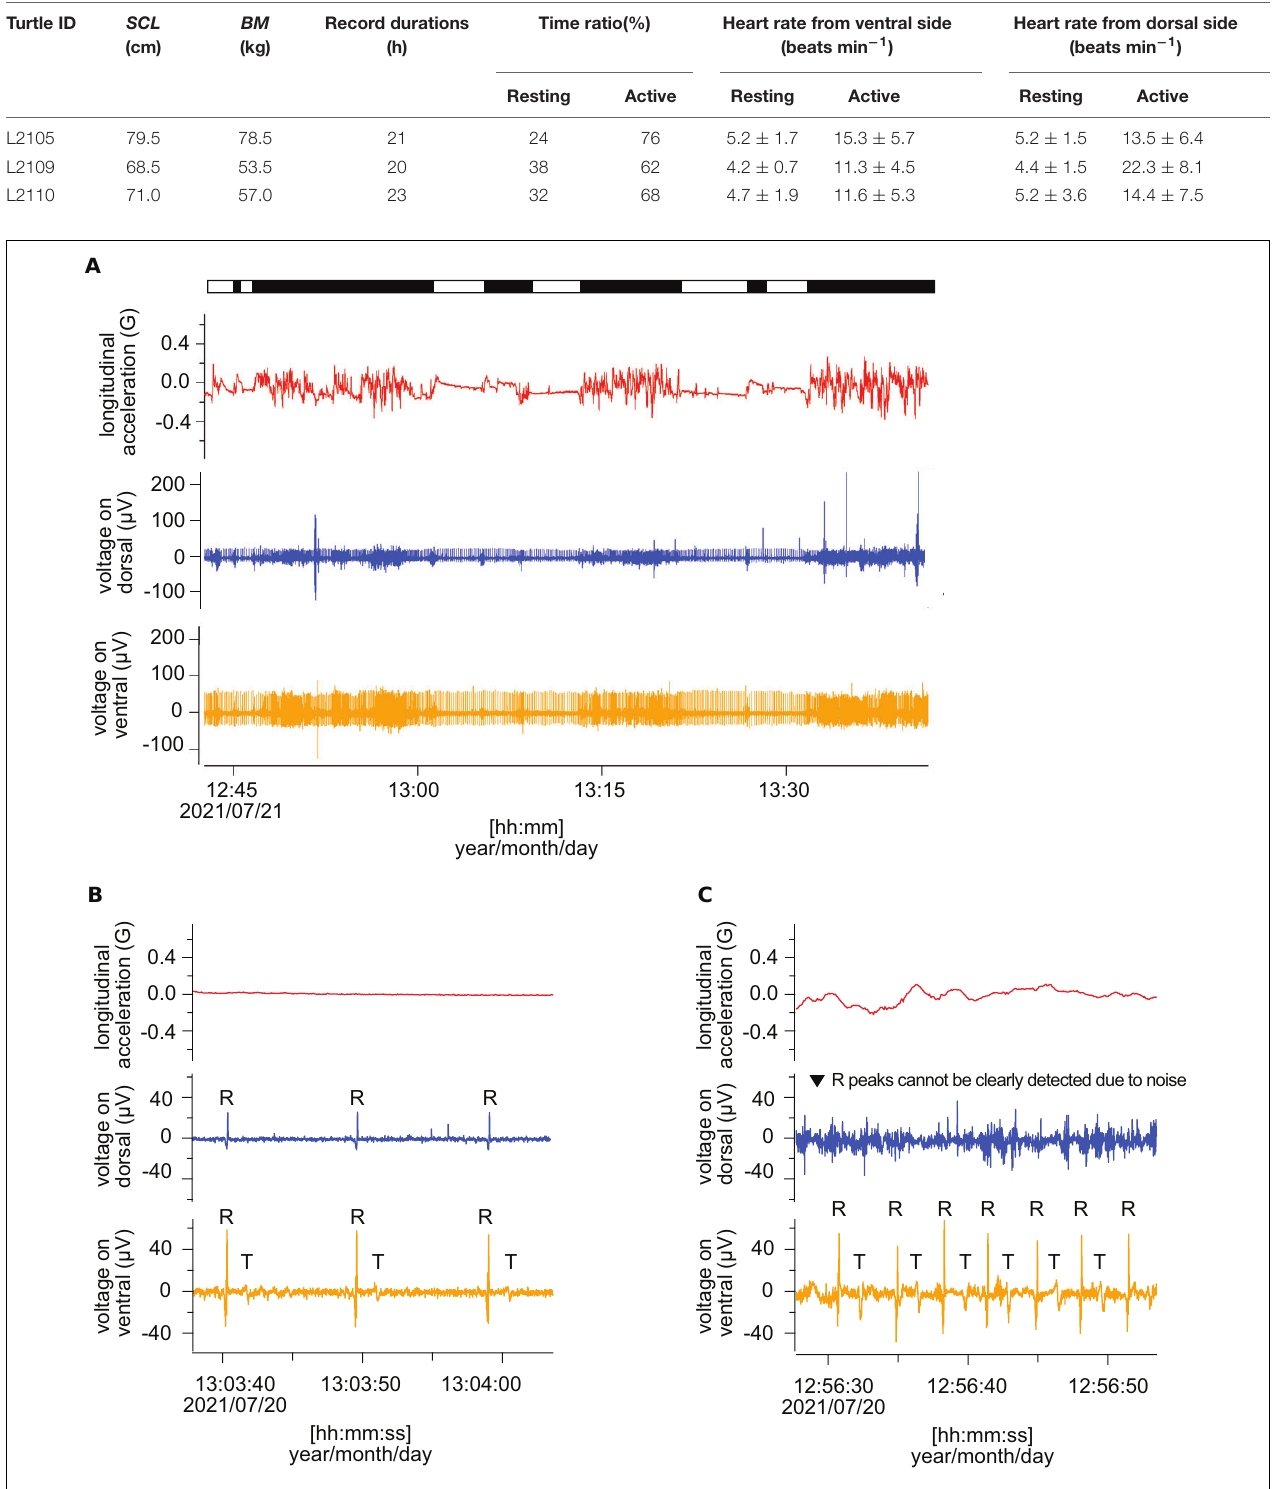
FIGURE 3 | Comparison of the measured ECG (before filtering) from dorsal and ventral sides. Red, blue, and orange lines indicate longitudinal acceleration, ECGs from dorsal and ventral sides, respectively. (A) The example of ECGs including resting and active phases. The bar above indicated active (black) and resting (white) phases. (B) ECGs in resting and (C) active phase. The R and T indicate R peaks and T peaks. All panels show the data from